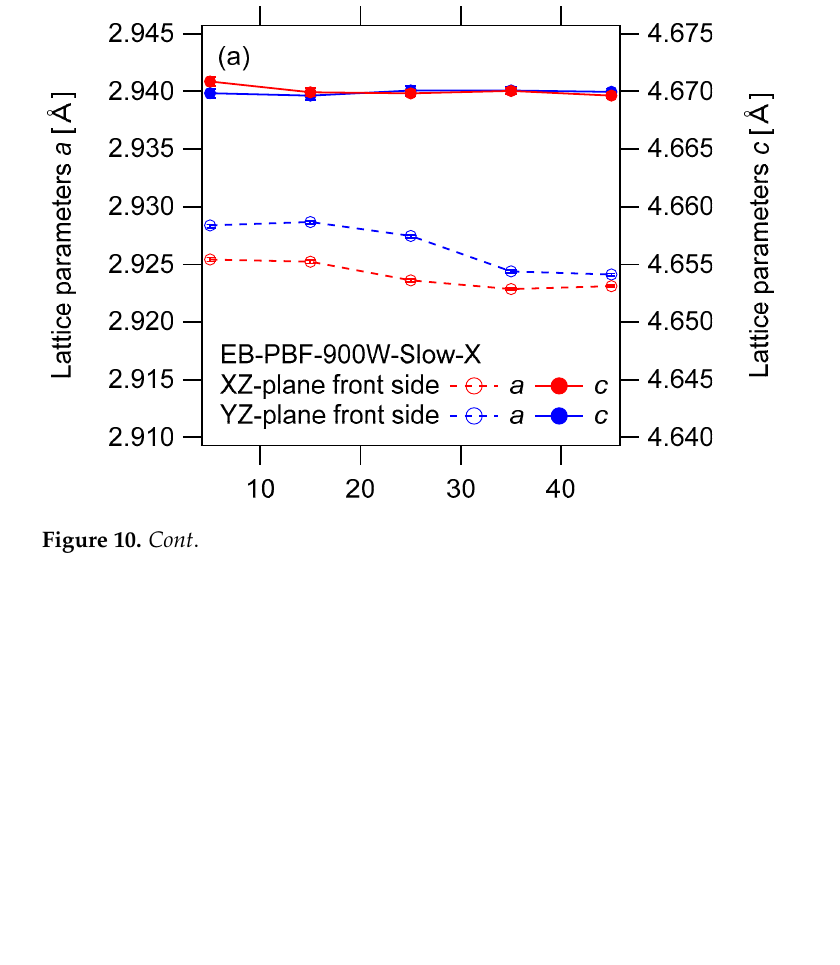
Figure 10. α or α ’ phase lattice parameters measured at different locations on ( a ) EB-PBF-900W-Slow-X and ( b ) EB-PBF-750W-Fast-X. The data points on the front sides, colored red and blue in Figure 1, are shown. The a -axis was long at the beginning of the growth process and then became shorter as the parts grew in the Z direction. This trend is more significant on the YZ plane than on the XZ plane.